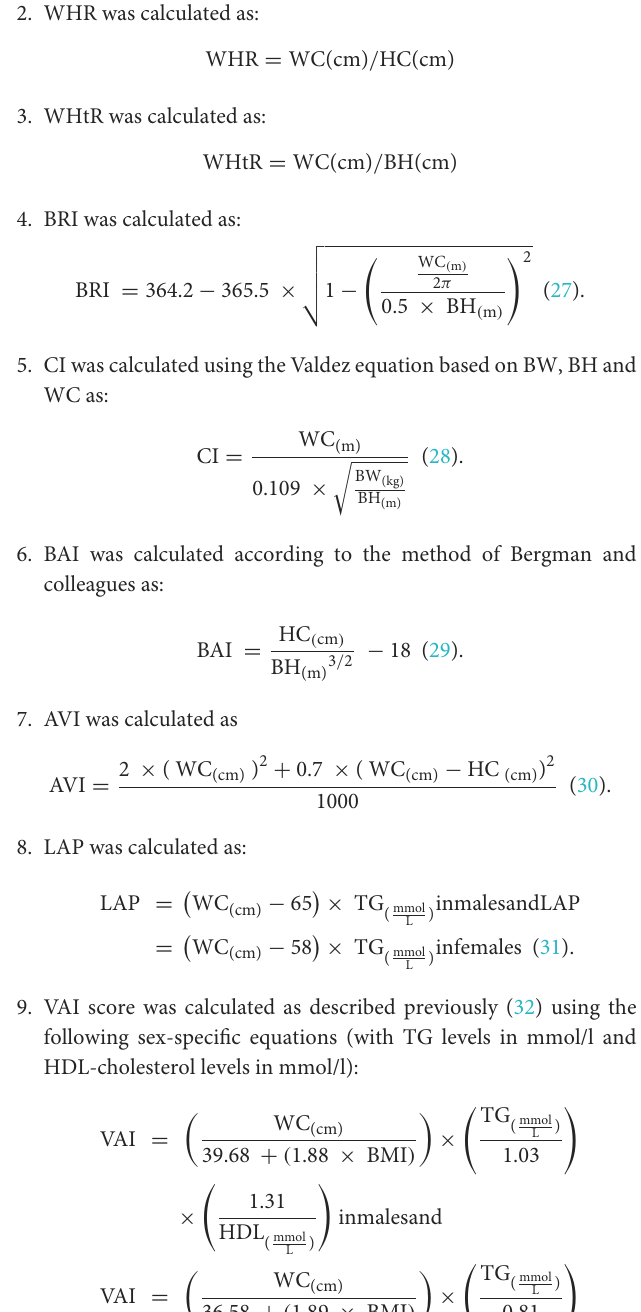
TABLE 1 Clinical characteristics of the study participants classified by